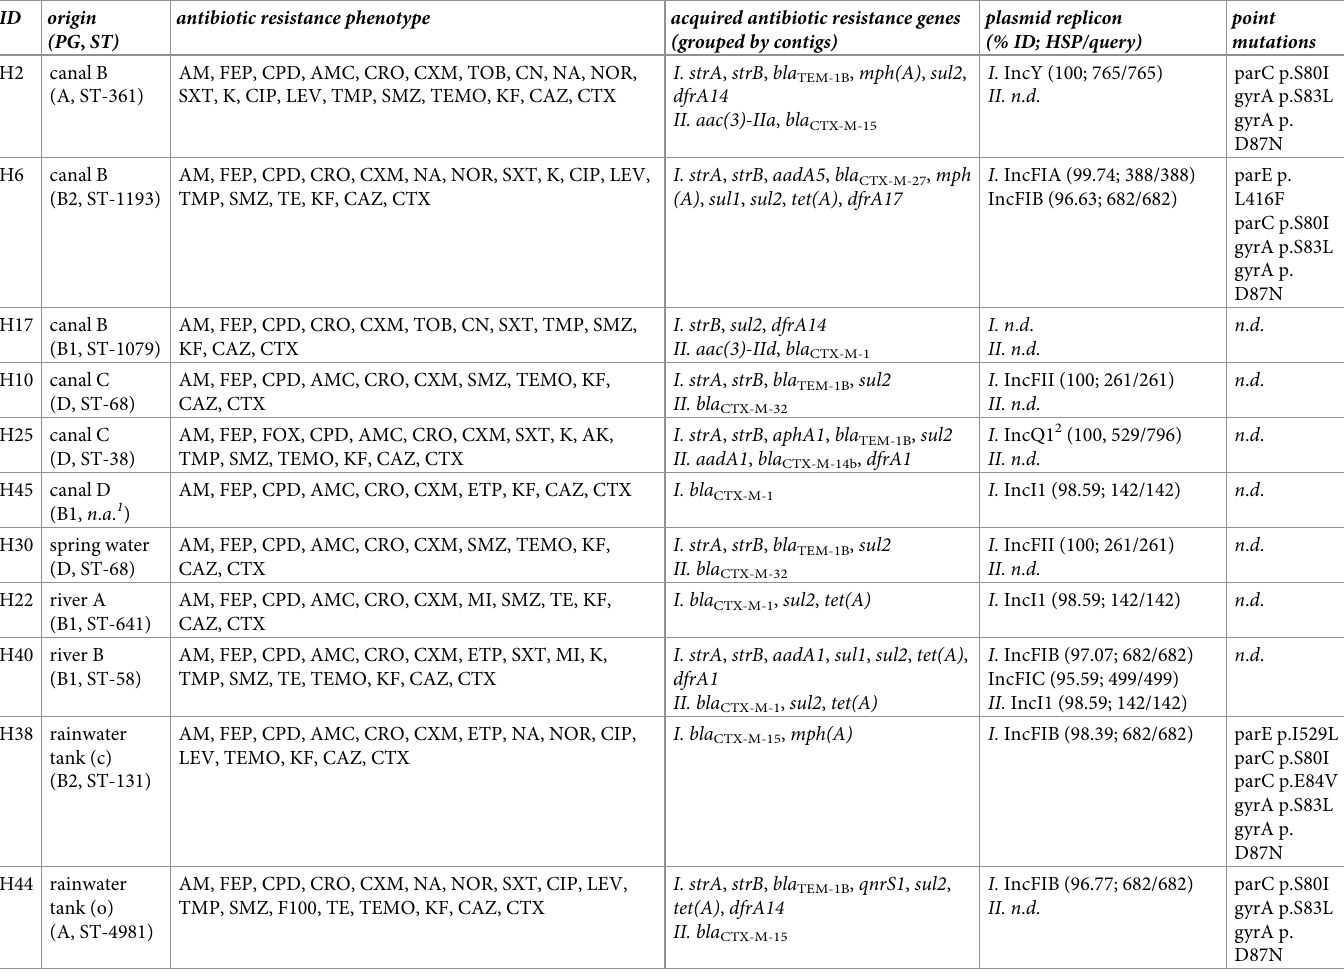
Table 3. Antibiotic resistance phenotype and genotype of ESBL-producing E . coli from irrigation